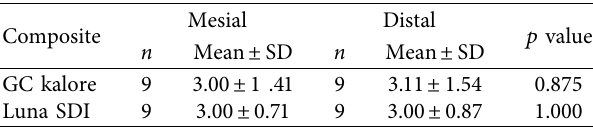
SD � std. deviation; n �